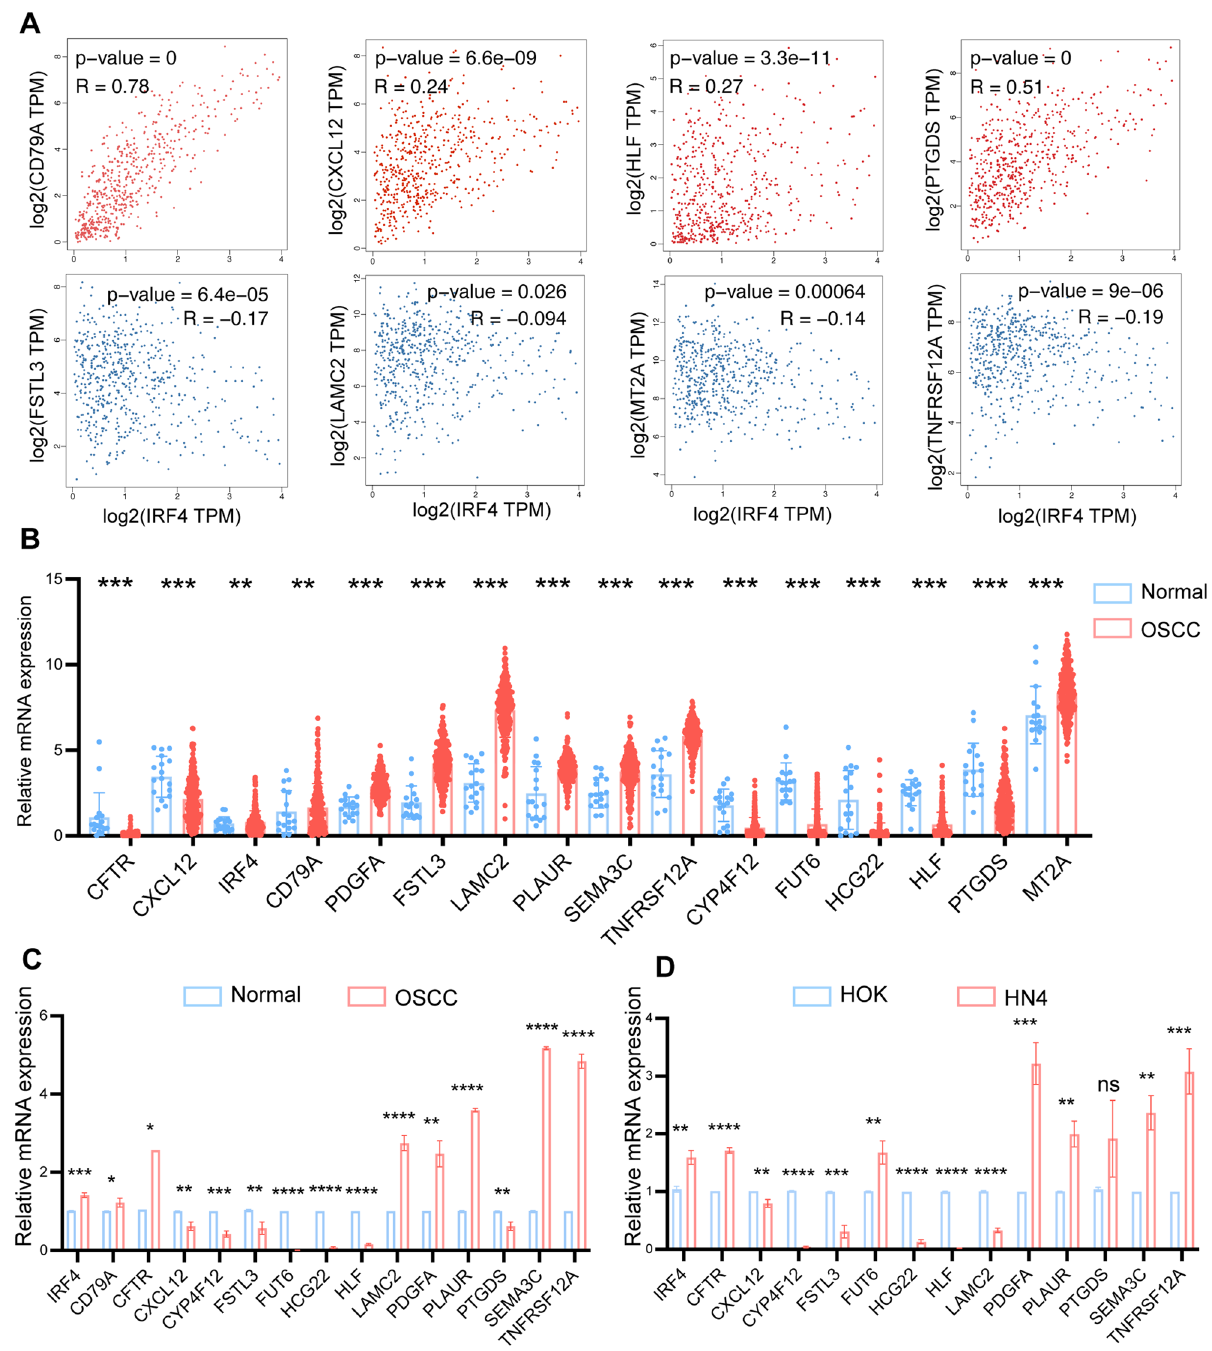
Figure 4. Identification and Validation of Hub Genes. ( A ) Correlation of IRF4 expression with other representative DEGs. ( B ) Expression data of DEGs in OSCC from TCGA database. ( C ) The mRNA expressions of DEGs by qRT-PCR in total RNA extracted from Normal and OSCC samples. ( D ) The mRNA expressions of DEGs by qRT-PCR in total RNA extracted from HOK and HN4 cell lines. ns, No significant; * p < 0.05; ** p < 0.01; *** p < 0.001; **** p <